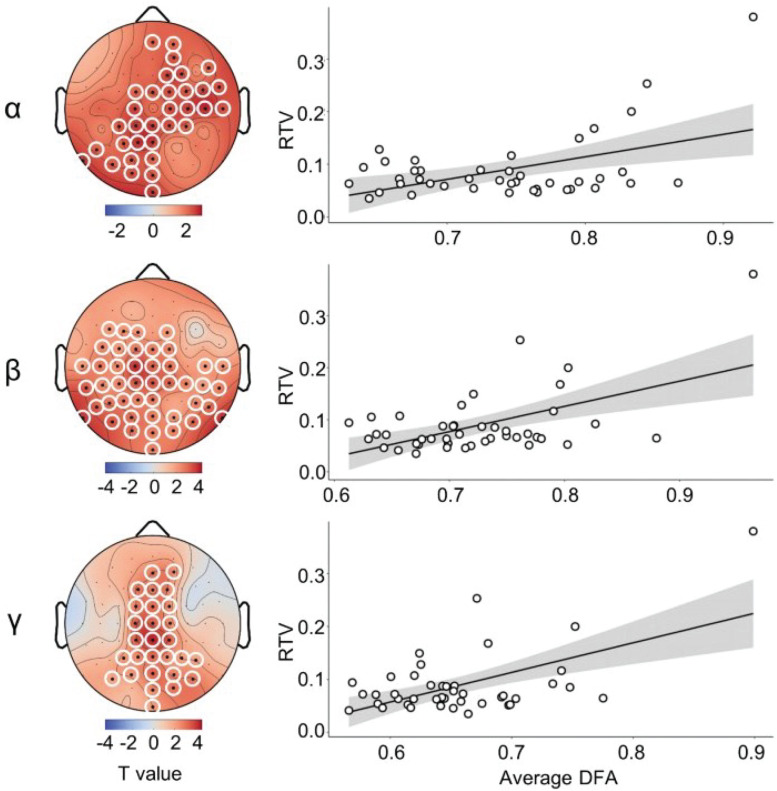
DFA predicts RTV. Left panel shows topographies of significant clusters in the alpha, beta, and gamma frequency range. Right panel shows the respective scatterplots, illustrating the relationship between RTV and the average DFA across electrodes in the cluster.